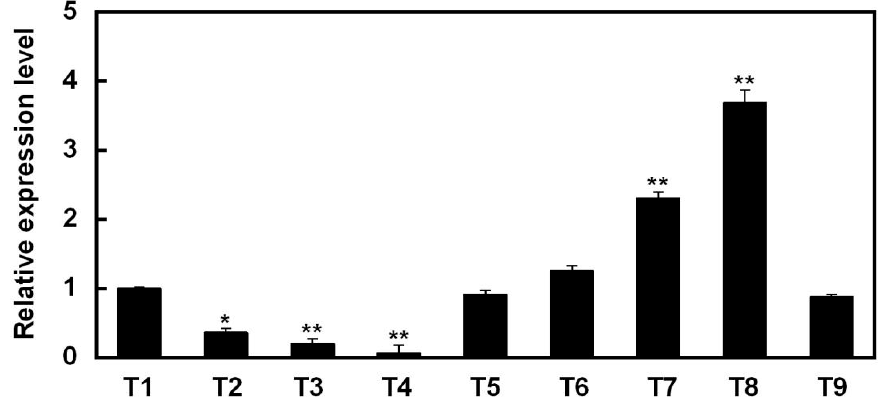
Figure 9. Relative expression of GmPLMT in soybean grains at different stages of maturity. T1–T9 represent the samples of pods collected every five days starting from the 35th day after flowering. Symbols “*” and “**” indicate significant differences at p values of 0.05 and 0.01, respectively, in comparison to T1.